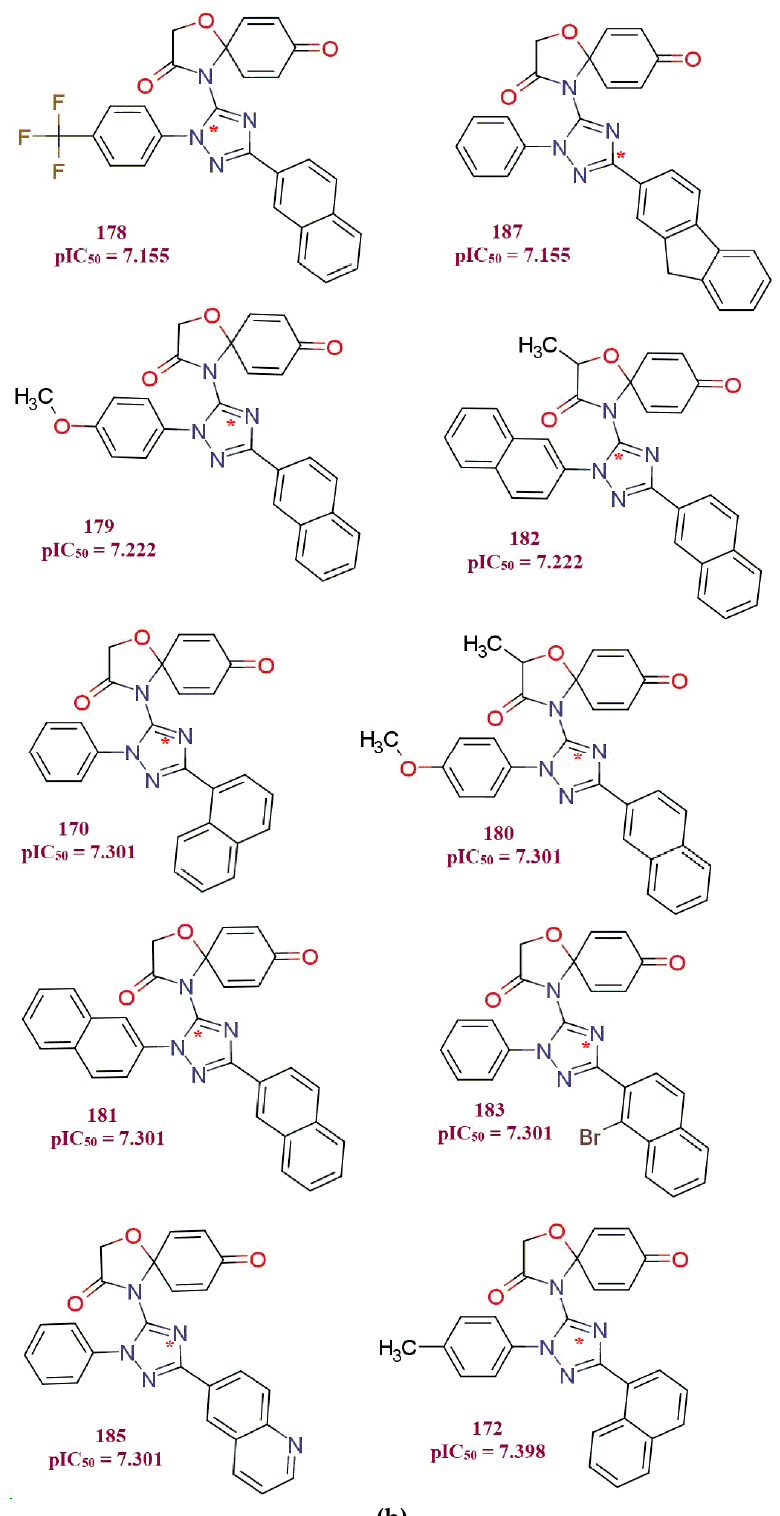
Figure 3. Variations in activity and chemical structures in the present dataset of MDA-MB-231 anti-prolifertives: (a) ten least active compounds; (b) ten most active compounds from the present series . Asterisks * mark denotes the position of the center of the mass of the molecules.